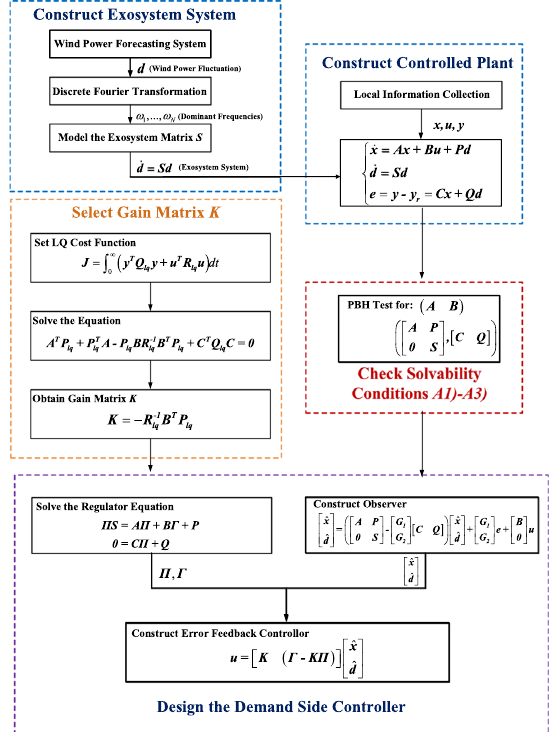
Fig. 6 The diagram of the regulator-theory-based control